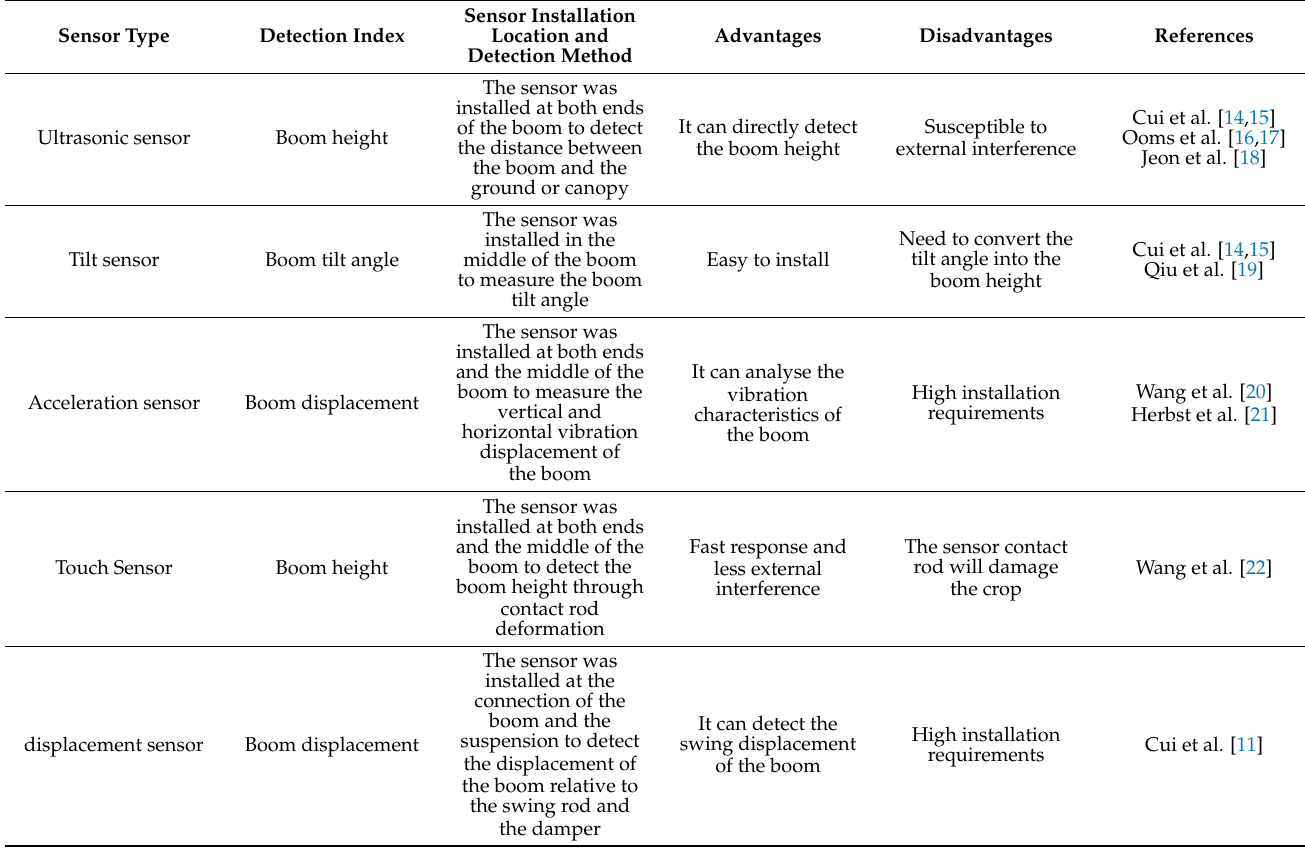
Table 1. Existing boom height detection